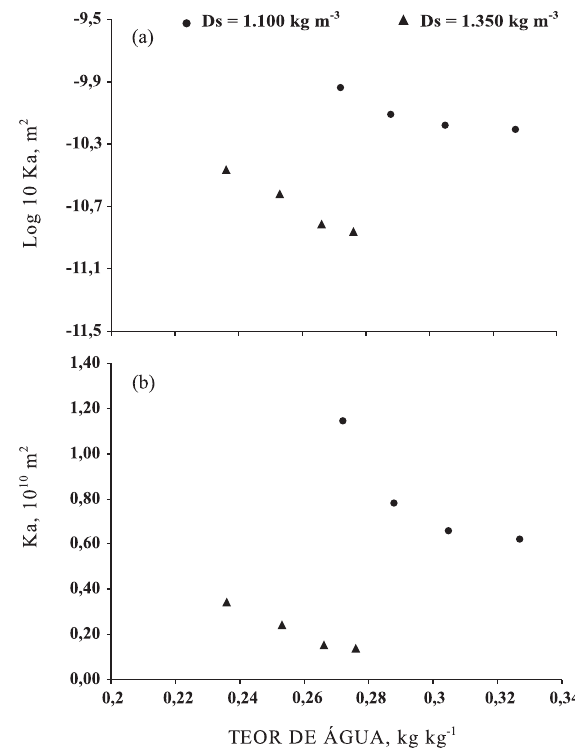
Figura 3. Relação entre a permeabilidade do solo ao ar e a umidade gravimétrica para um Nitossolo Vermelho eutroférrico de textura argilosa em duas densidades. Resultados expressos conforme McKenzie & Dexter (1996) (a). Resultados expressos conforme Otten et al. (1999) (b).